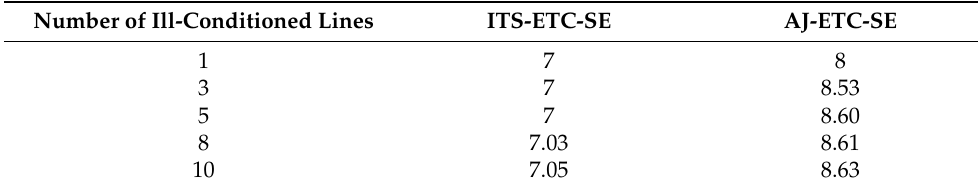
Table 8. Iteration numbers with ill-conditioned